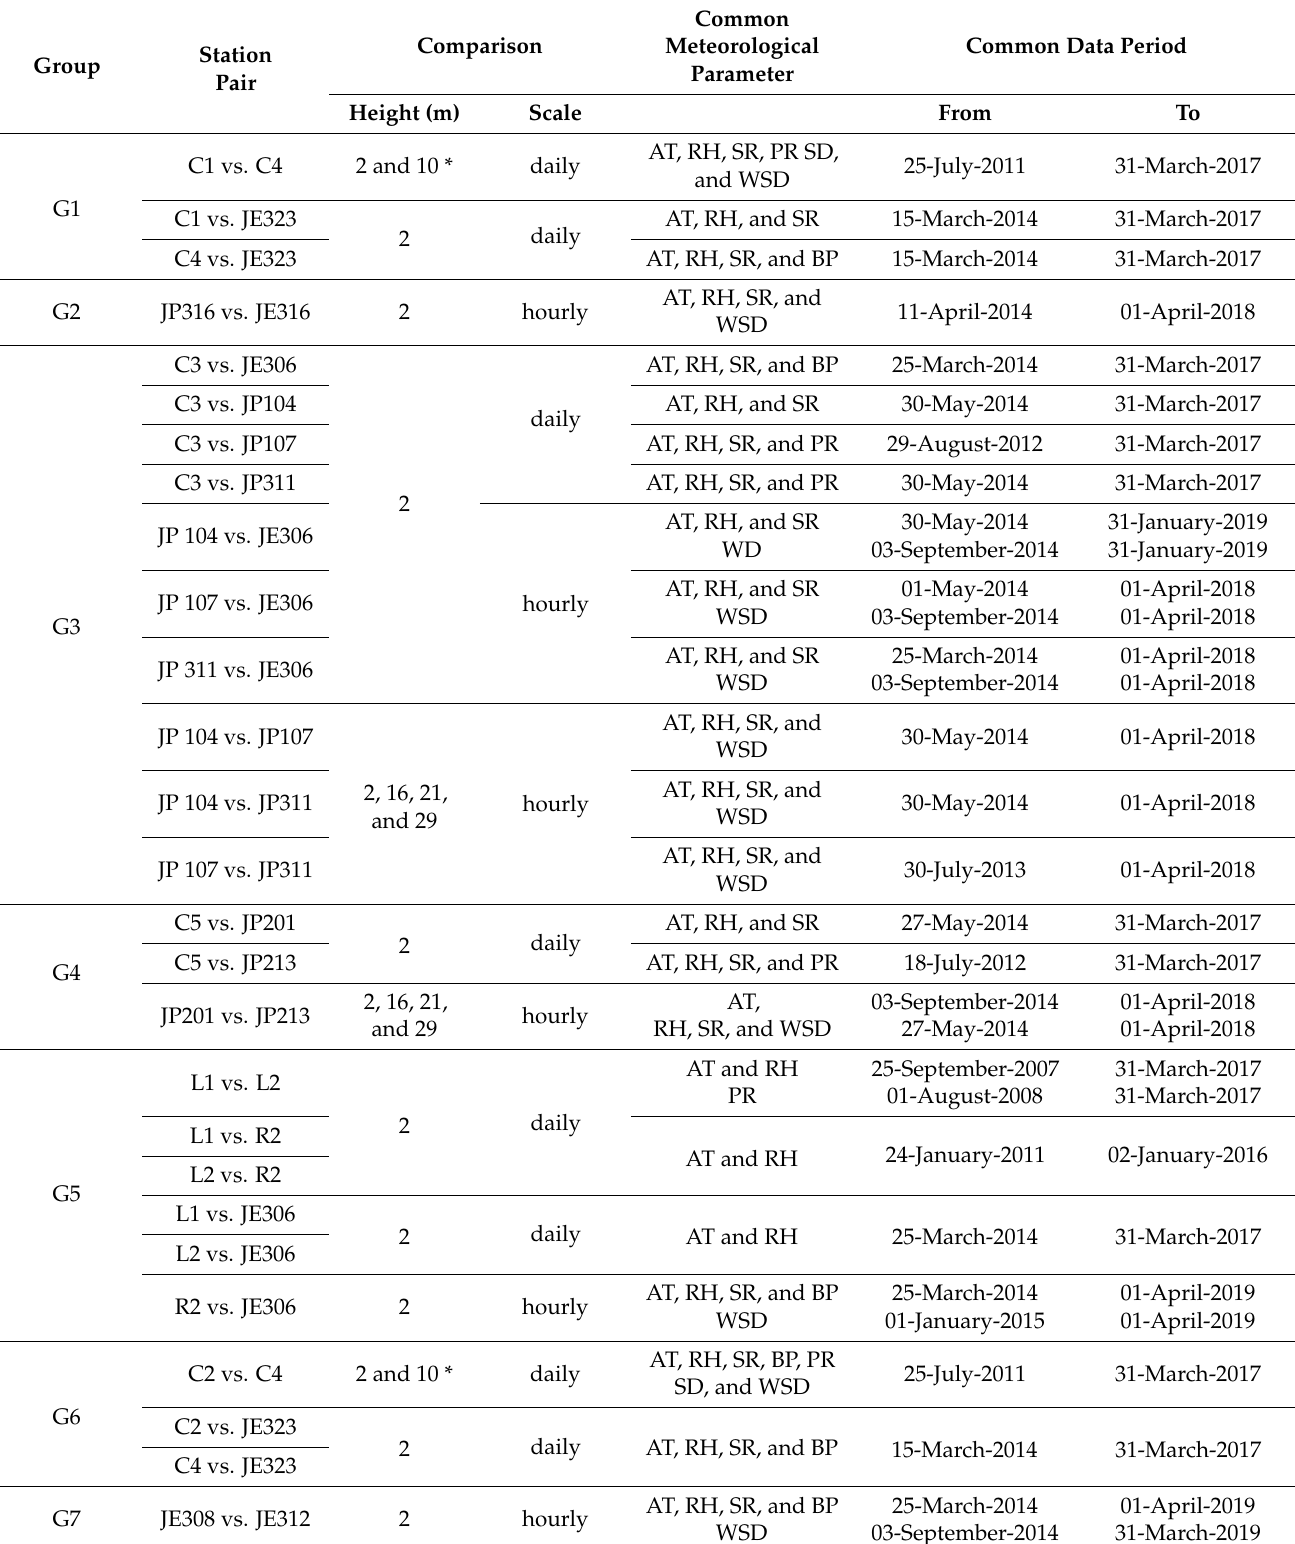
Table 1. A brief description of the available data records for each of the seven groups (as illustrated in Figure 1) used in this